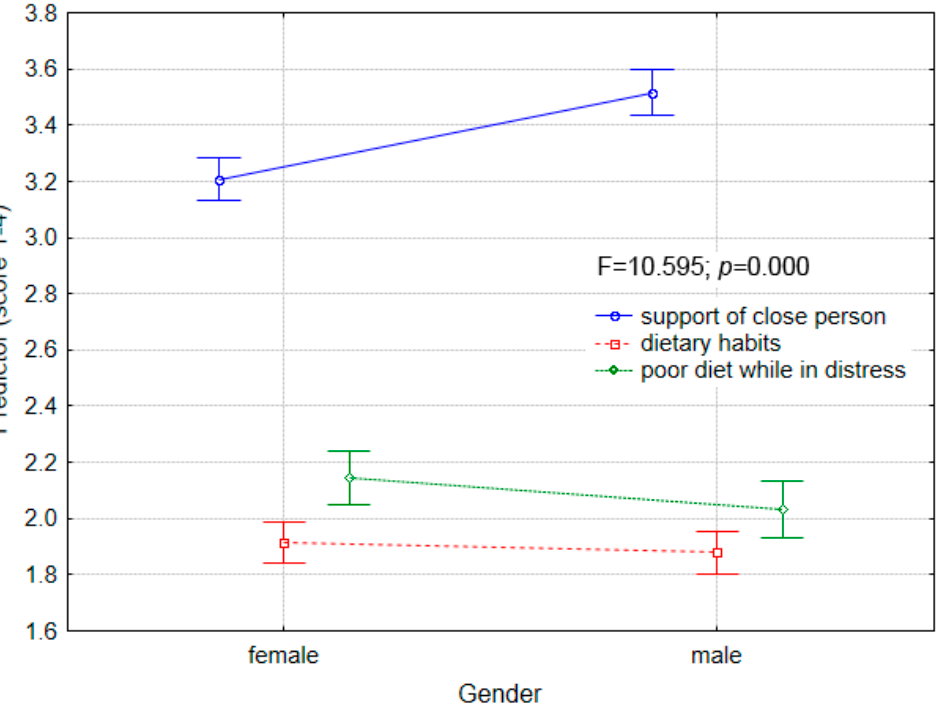
Figure 2. Descriptive statistic results of supplementary questions by